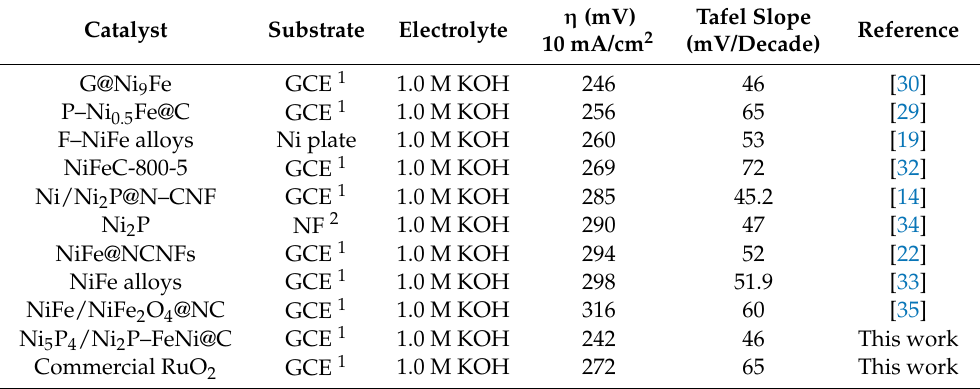
Table 1. Comparison of OER activity of different electrocatalysts at 10 mA cm − 2